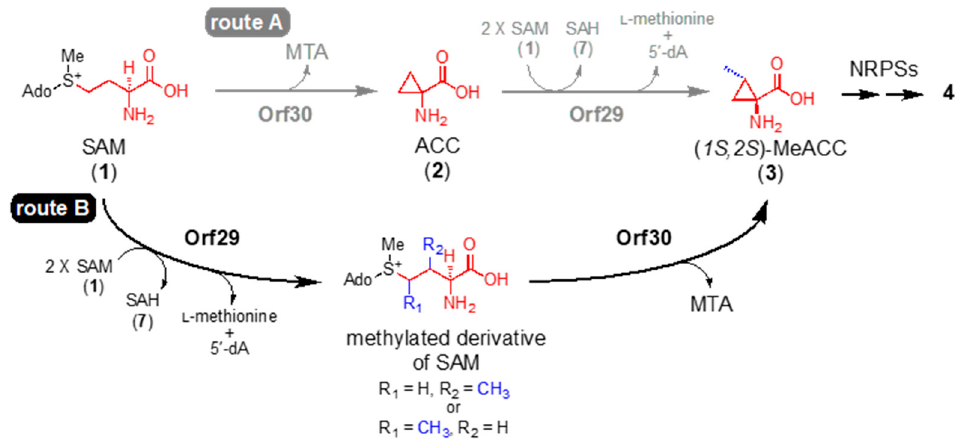
Figure 4. Biosynthetic routes from S -adenosyl- L -methionine (SAM) to MeACC in vitro. Two biosynthetic routes to 3, route A and route B, were proposed in this study.